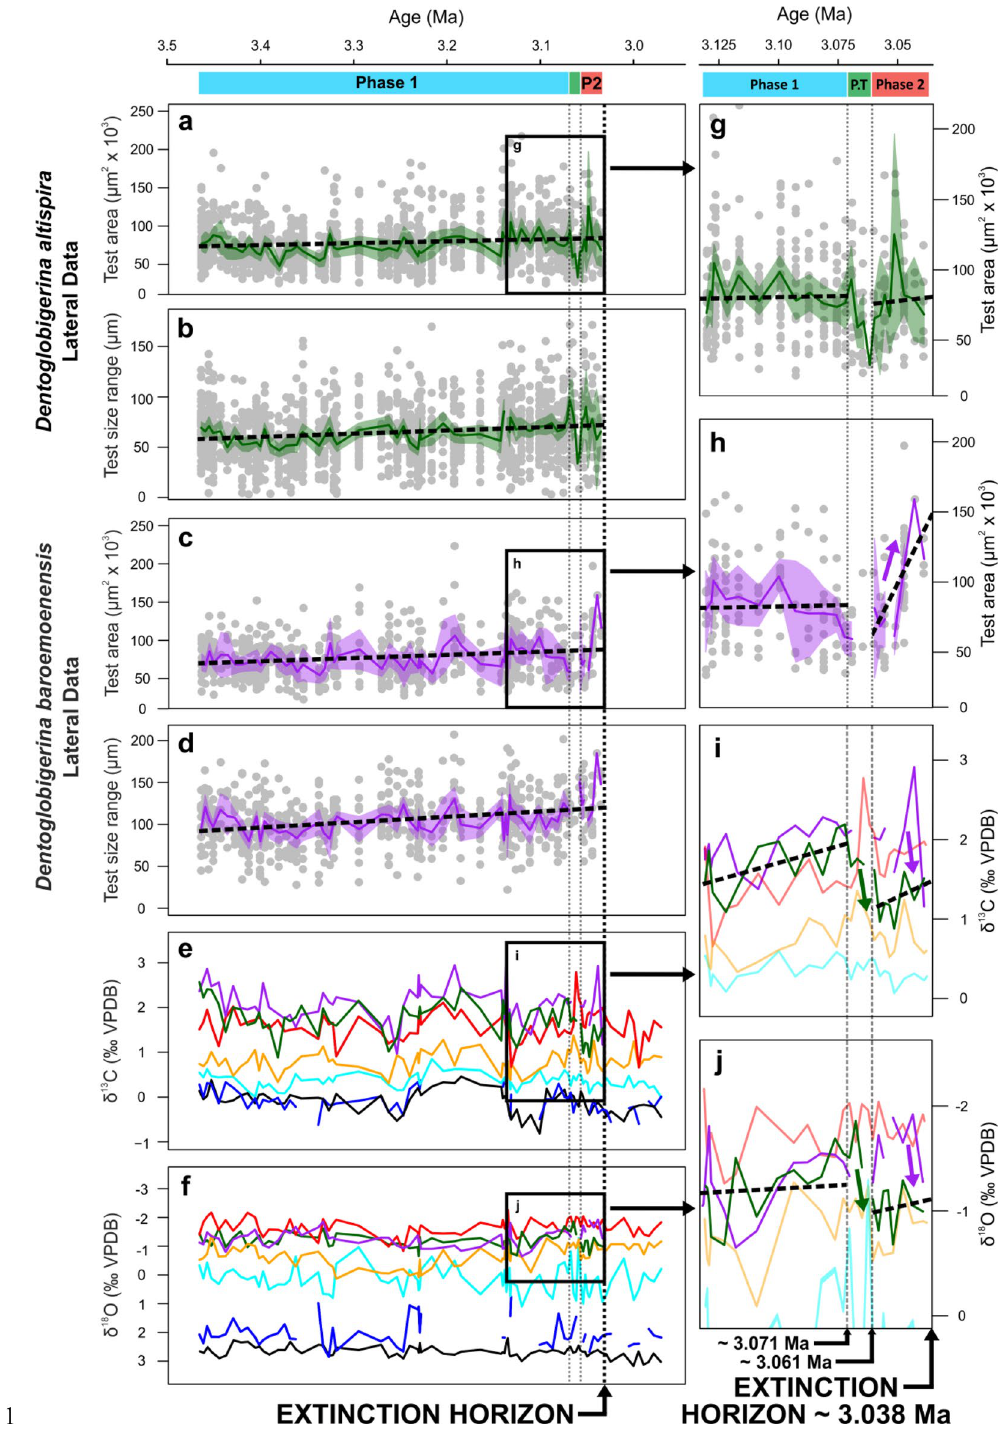
Figure 1. Stratigraphic log of Hole U1338A with geochemical and biotic records through dentoglobigerinid extinction event. ( a ) D. altispira Area, ( b ) and size range, ( c ) D. baroemoenensis Area, ( d ) and size range, ( e ) Single and multi-specimens planktonic foraminiferal δ 13 C, ( f ) Single and multi-specimen planktonic foraminiferal δ 18 O, ( g – j ) blown up dentoglobigerinid Area, and isotope data in pre-extinction interval. Black = bottom-water , dark blue = subthermocline, cyan = thermocline, orange = subsurface , red = surface mixed layer, green = D. altispira , purple = D. baroemoenensis. Solid coloured lines for dentoglobigerinids are mean values of multiple single specimen analyses, shaded areas are 95% confidence intervals, black dashed lines are species trendlines, light vertical dotted lines indicate boundaries between “Phases”, black vertical dotted line indicates extinction horizon. P2 Phase 2, P.T Phase